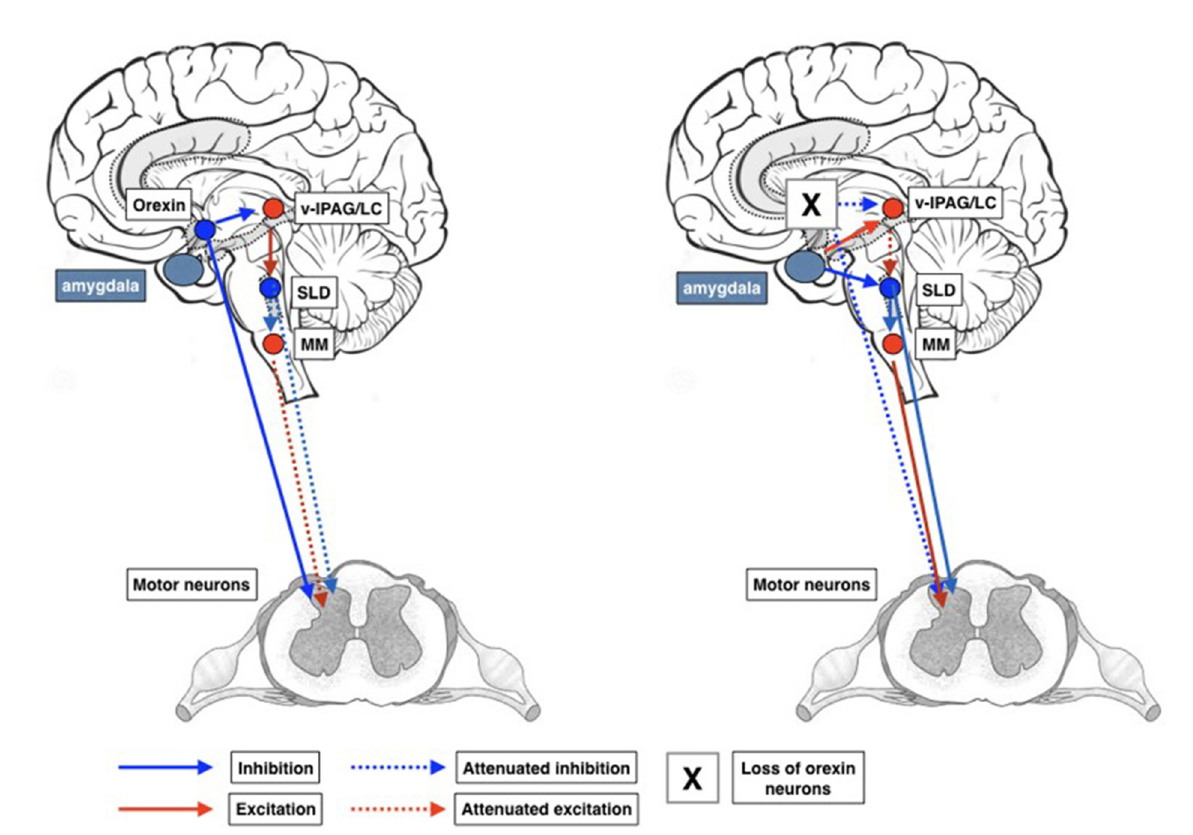
FIGURE5 Schematic representation of circuits involved in the development of cataplexy. Inappropriate activation of the REM sleep atonia circuitry during wakefulness is thought to produce cataplexy. Glutamatergic REM-active SLD neurons trigger the paralysis of REM sleep via stimulation of the GABAergic/glycinergic cells in the MM. These MM neurons send inhibitory projections to skeletal motor neurons. Under normal conditions, strong positive emotions are processed via GABAergic neurons of the CeA, which then inhibit cells in the LC and vlPAG. However, in the absence of the LH hypocretinergic neurons in cataplexy, this inhibition fails, so the REM sleep atonia circuit is released from inhibition and triggers muscle paralysis while the individual remains conscious. The inhibition of LC neurons during cataplexy removes noradrenergic inputs to motoneurons, thereby enhancing the muscle paralysis of cataplexy. CeA, central nucleus of the amygdala; GABA, γ -aminobutyric acid; LC, locus coeruleus; LH, lateral hypothalamus; MM, ventral medial medulla; SubC, subcoeruleus; vlPAG, ventrolateral periaqueductal gray; MNs, motoneurons.